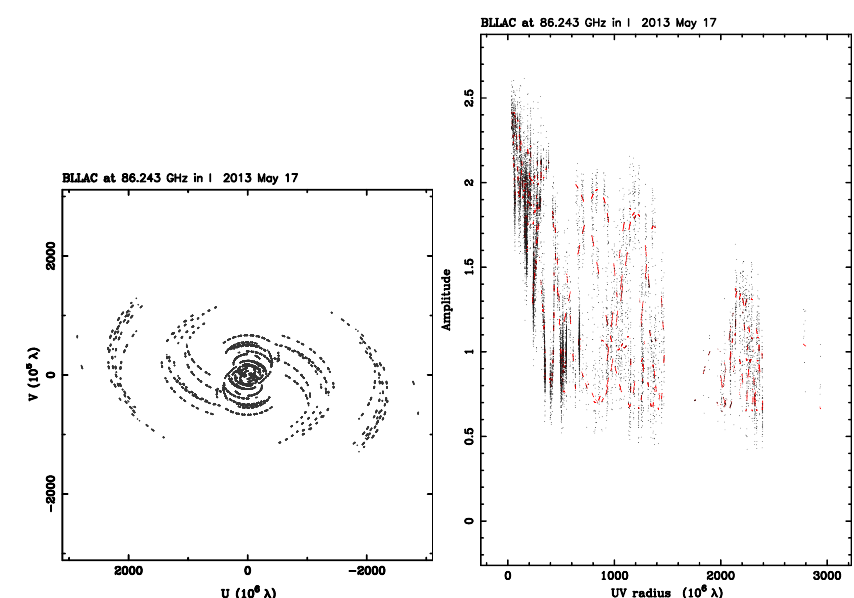
Figure 1. ( Left ): UV-plot for BL Lac at 86 GHz on May 17, 2013; ( Right ): Correlated flux versus projected baseline (data in dark-grey and source model in